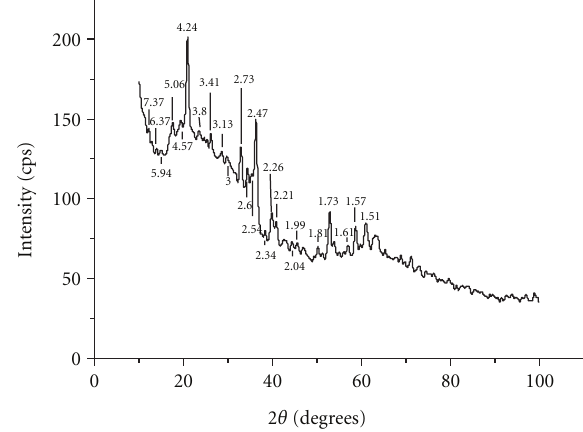
Figure 4: X-ray di ff ractogram of the products formed after the cylinders were exposed to the water + 10% B3 fuel for a period of 15